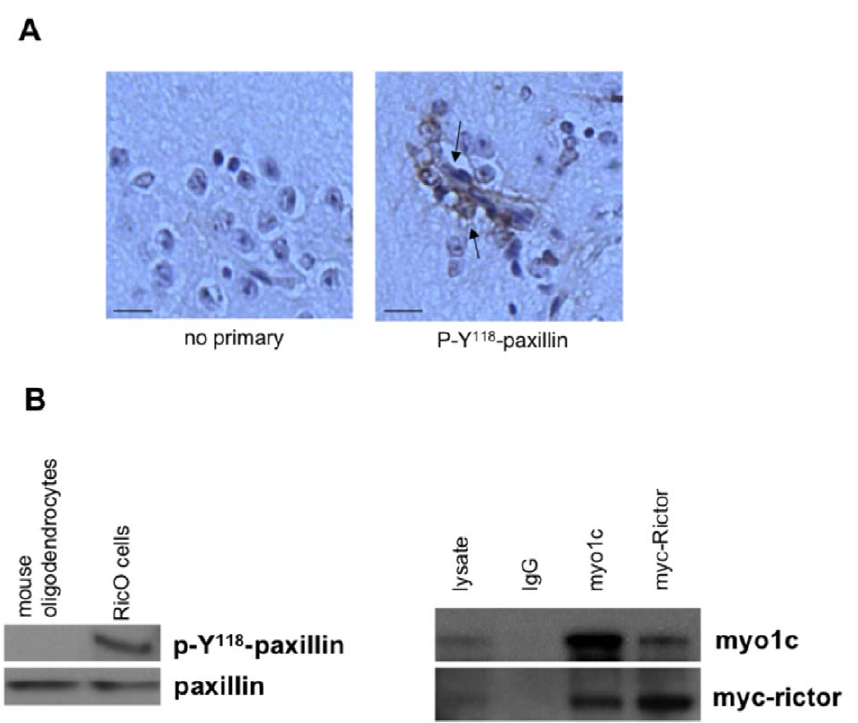
Figure 3. GFAP-Cre/Rictor loxp/loxp gliomas demonstrate mTORC2-independent signaling. (A) Elevated phospho-Y 118 -paxillin staining in GFAP-Cre/Rictor loxp/loxp gliomas. Left panel, no primary antibody; right panel, anti-phospho-Y 118 -paxillin antibody. Scale bar; 20 m m. (B) Elevated phospho-Y 118 -paxillin levels in Ric0 cells as determined by immunoblot analysis (left panel); co-immunoprecipitation of the myc-tagged Rictor-Myo1C complex in Ric0 cells (right panel). Whole cell lysate was immunoprecipitated with the indicated antibodies and immunoprecipitates were immunoblotted for either Myo1C or the myc-tag. cytoplasm and many of these cells stained immuno-positive for GFAP (Figure 6C, right panel). Cells within the expanded SVZ stained positive for Ki-67 and phospho-S 473 -AKT in both GFAP- Cre/Rictor loxP/loxP and GFAP-EGFRvIII; GFAP-Cre/Rictor loxP/loxP mice (Figure 6D) and a greater number of SVZ phospho-S 473 -AKT immunopositive cells were observed in the GFAP-EGFRvIII; GFAP- Cre/Rictor loxP/loxP mice compared with age-matched GFAP-Cre/